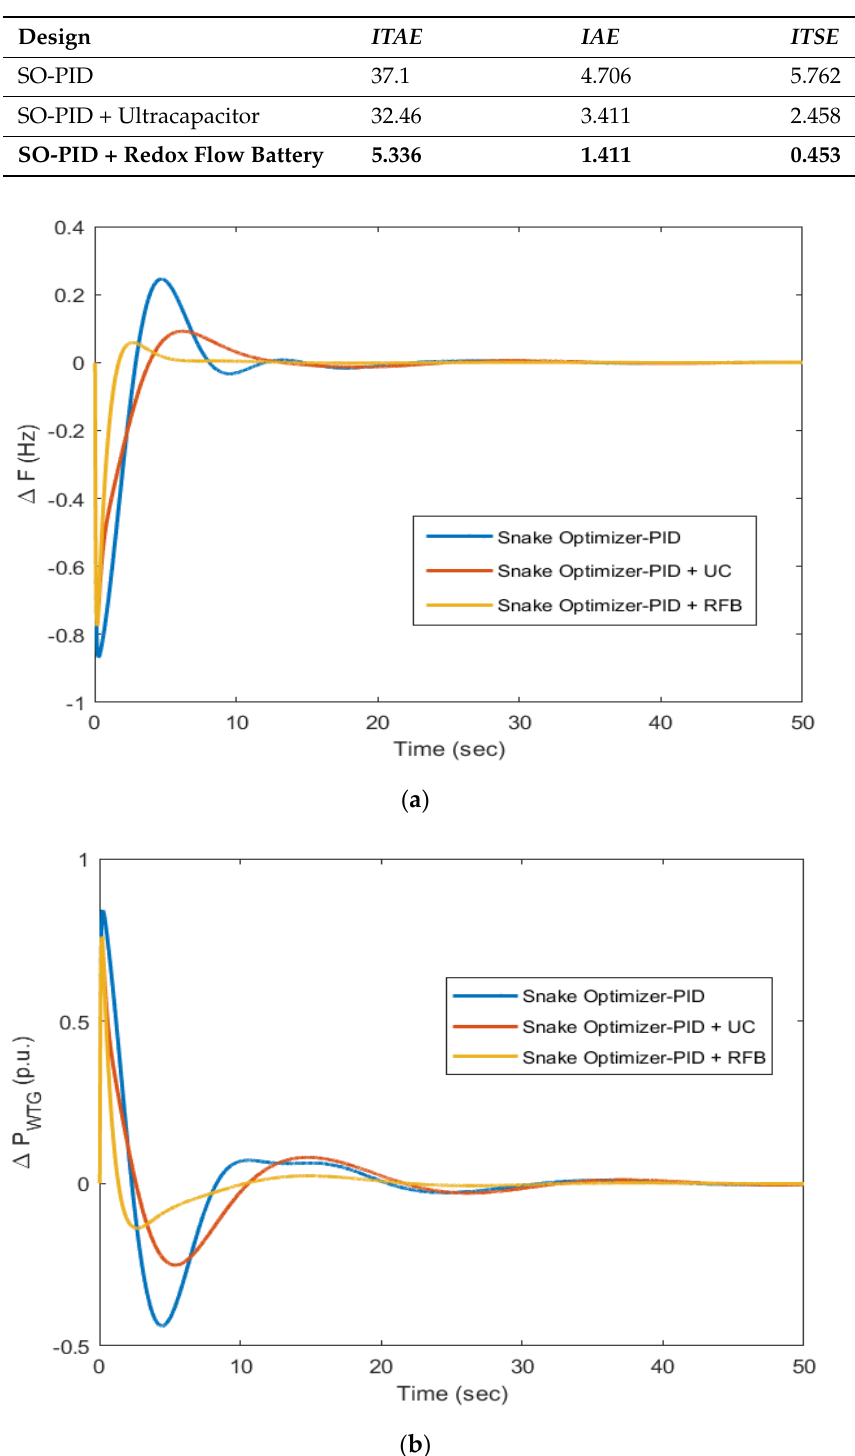
Table 4. SO-PID output matched by adding an RFB or UC. The results were obtained for a 1.0 p. u. step load alteration.